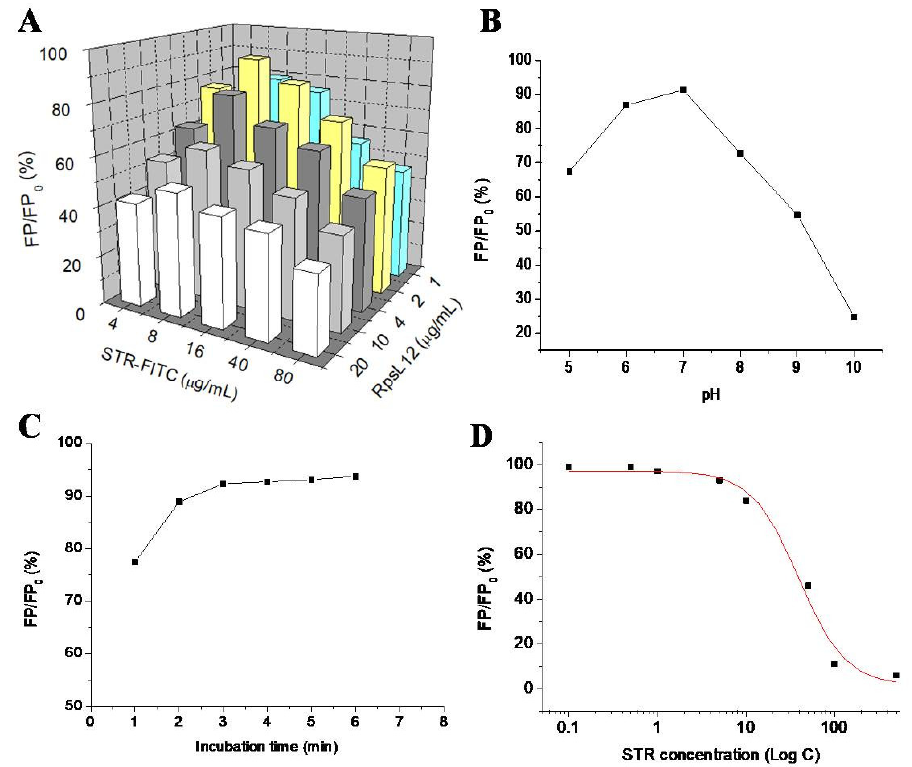
Figure 6. Results for optimization of ( A ) RpsL 12/STR-FITC concentration (pH 7.0, incubation 5 min), ( B ) pH (STR-FITC 8 µ g/mL, RpsL 12 2 µ g/mL, incubation 5 min), and ( C ) incubation time (STR-FITC 8 µ g/mL, RpsL 12 2 µ g/mL, pH 7.0) by using STR (100 ng/mL). ( D ) Competitive inhibitory curve of STR (0.1–500 ng/mL).